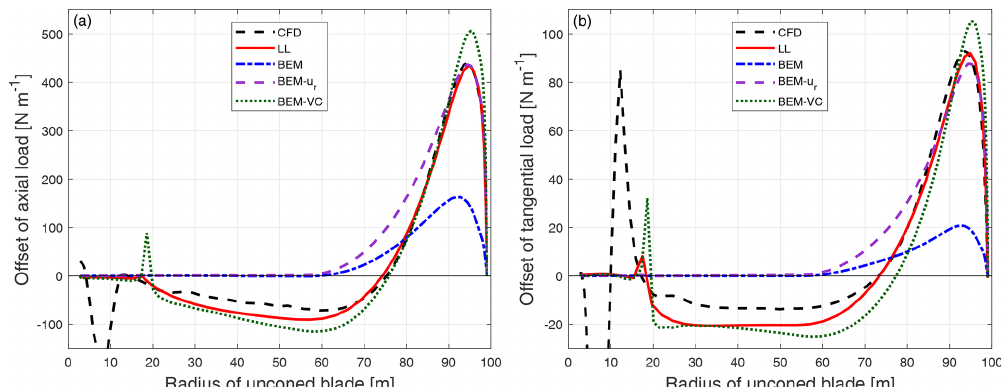
Figure B7. Comparison of the difference of the axial load (a) and tangential load (b) of the dihedral blade W-2 with 15 ◦ of cone downwind compared to the baseline blade with the same cone calculated from CFD, the lifting-line method (LL), the BEM method, BEM with radial induction (BEM- u r ) and the proposed BEM-VC method.